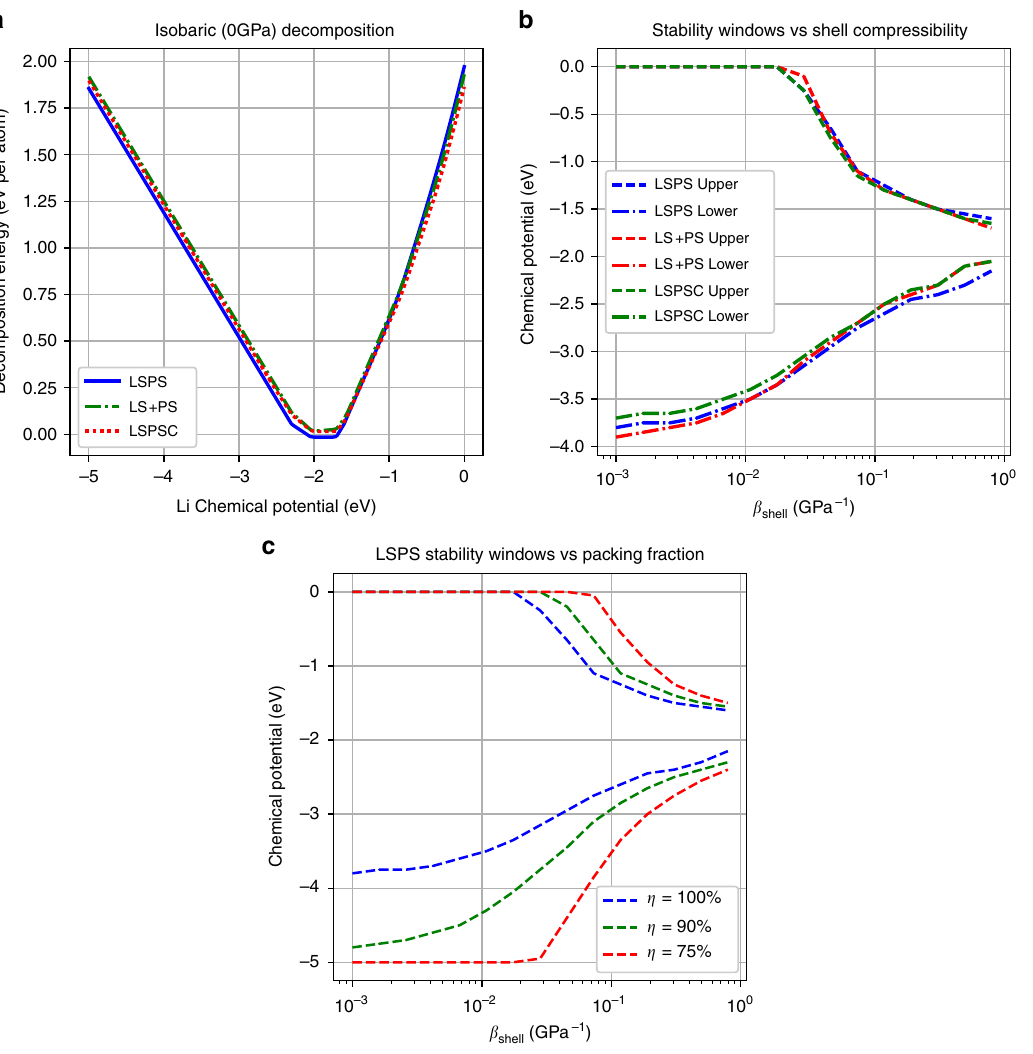
Fig. 6 Computational simulation results showing the effects of doping and shell compressibility on stability windows of LSPS-based solid electrolytes. a Zero-pressure decomposition energy for Li 10 SiP 2 S 12 (LSPS), Li 10 Si 1.5 P 1.5 S 11.5 Cl 0.5 (LSPSC), and Li 10 Si 1.5 P 1.5 S 12 (LS + PS). b Stability windows for LSPS, LSPSC, and LS + PS as a function of shell effective compressibility. The zero limit of β shell (left extreme of x- axis) corresponds to a perfectly rigid shell (isovolumetric decay). β shell ≫ β core (right extreme of x- axis) corresponds to no shell (isobaric decay). c Stability window for LSPS at different decay packing fractions. Stability was only considered within the range of 0 – 5 V vs.